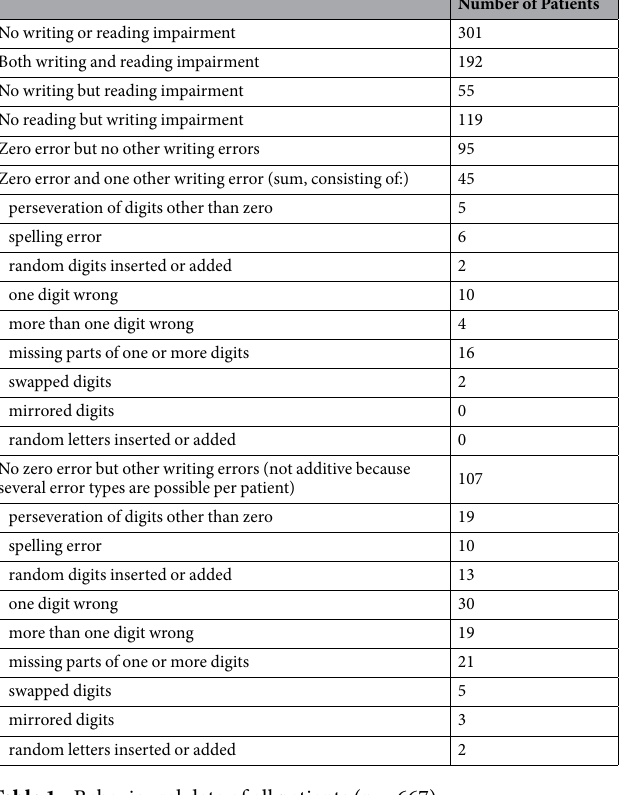
Table 1. Behavioural data of all patients (n = 667).